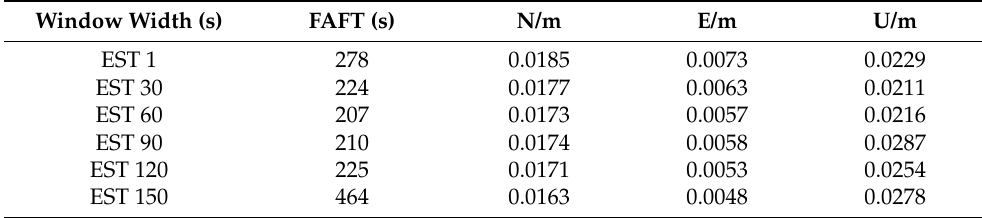
Table 6. The FAFT and positioning accuracy using the PSD estimated with different smoothing window